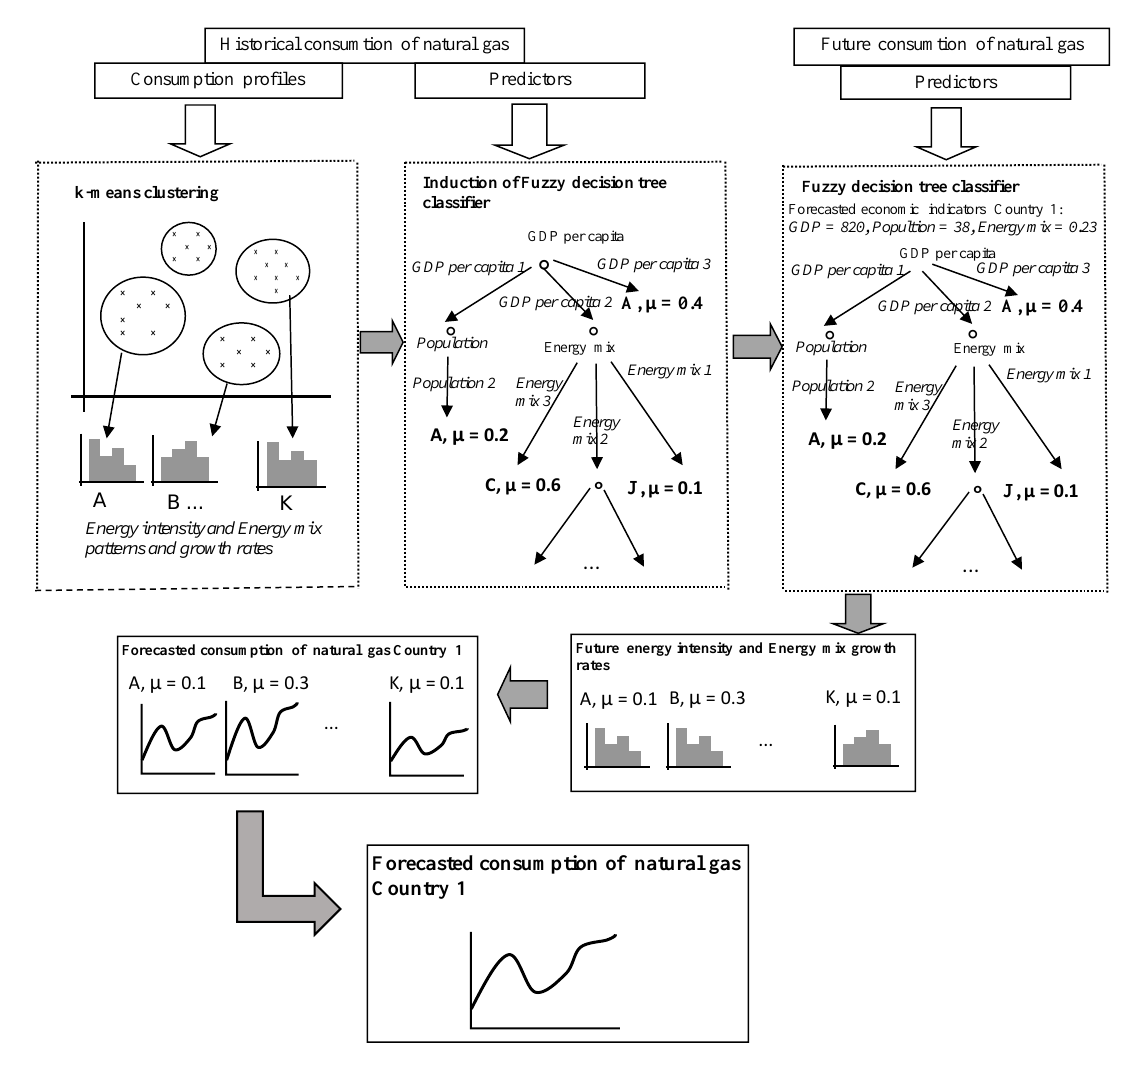
Figure 1. Forecasting algorithm diagram.